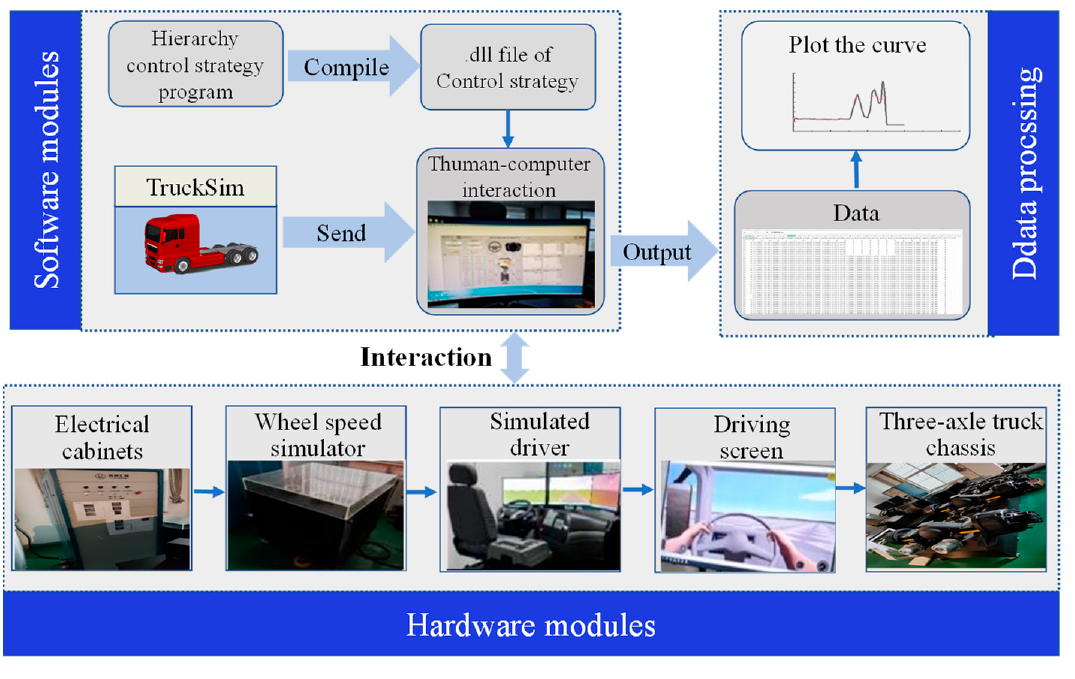
Figure 10. HIL flowchart.